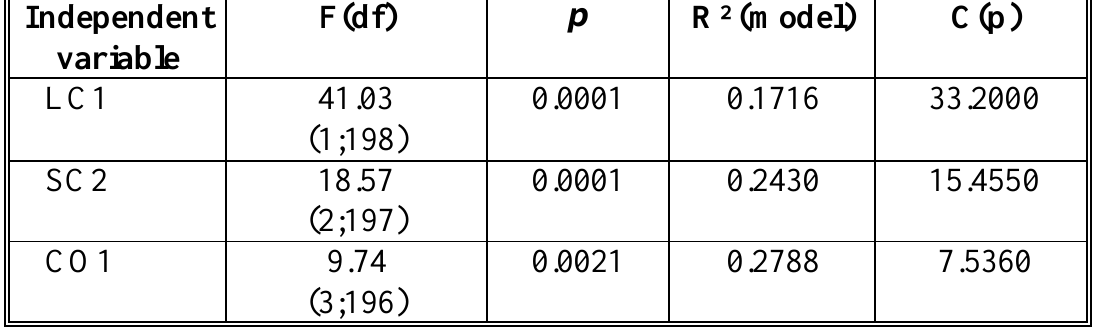
Table 12 indicates that the achievement/personal control sub-scale’s prediction model for pharmacists included three of the personality sub-scales with a total prediction of 27.88 per cent of the variance in the dependent